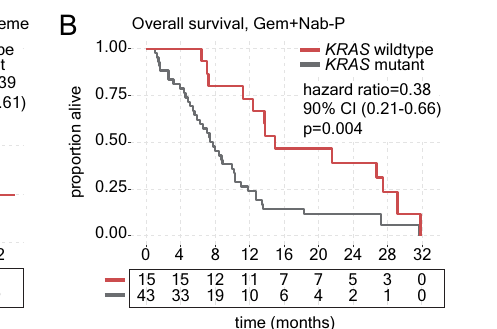
versus mutant tumors in the gemcitabine, nab-paclitaxel (Gem+Nab-P) treatment group. Hazard ratio and con fi dence intervals (CIs) based on strati fi ed Cox models areshownalongwithlog-rank p values,and statisticaltestsweretwo-sided.Source data are provided as a source data fi